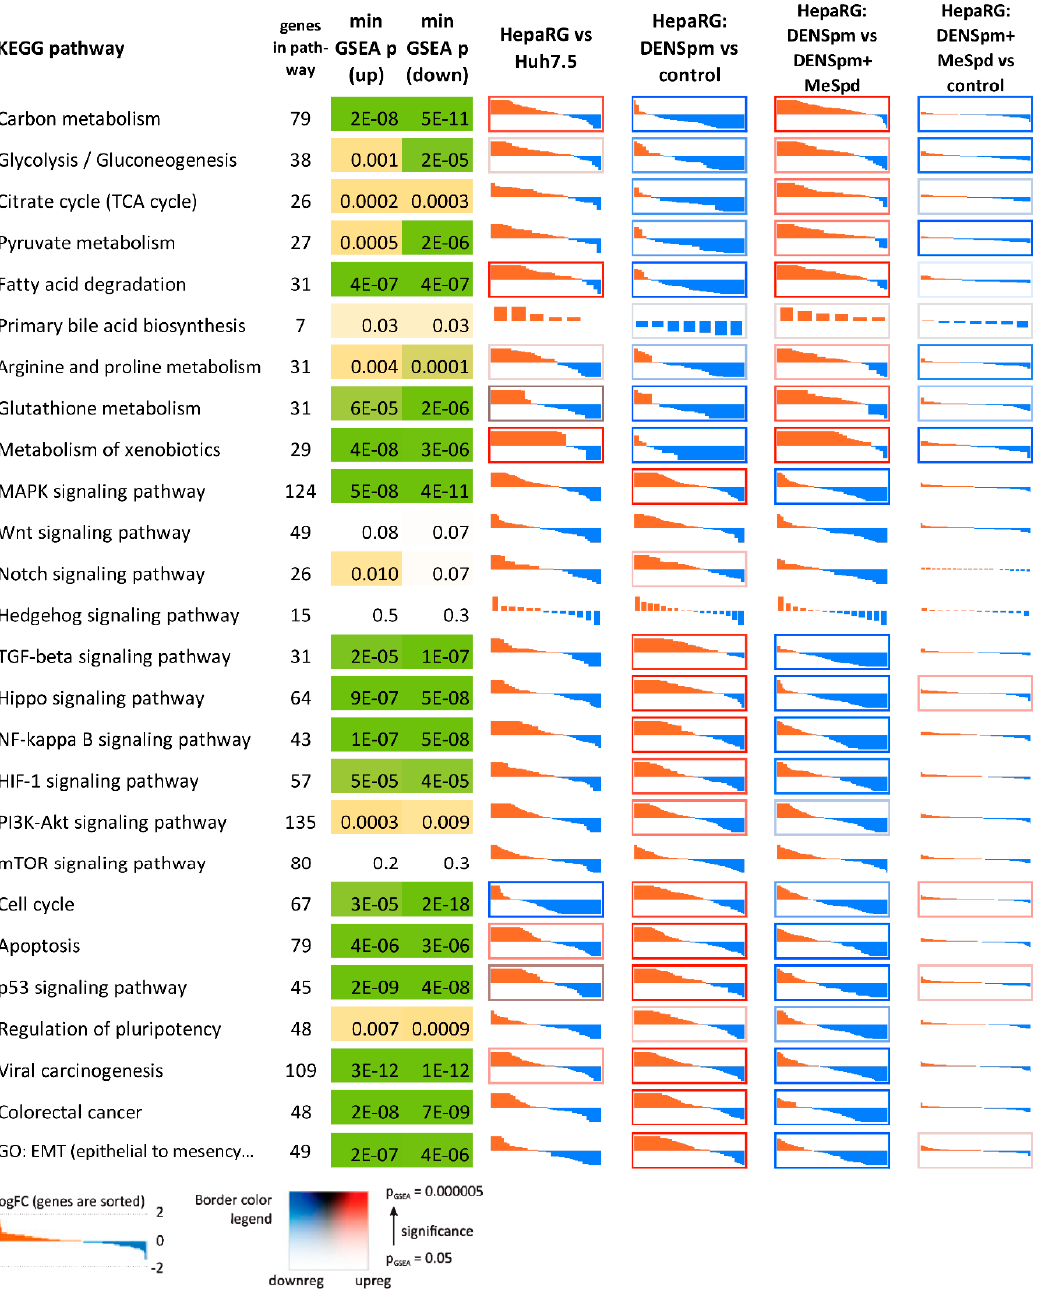
Figure 7. Differential expression profiles of genes involved in the key cell signaling pathways processes (KEGG pathways and two GO terms). Each cell represents log-transformed expression level fold changes (LogFC) of individual genes, sorted from overexpressed (red) to downregulated (blue). In each cell, vertical axis range is from LogFC = − 2 (i.e., 4-fold downregulation; blue) to LogFC = +2 (i.e., 4-fold overexpression; red). Cell borders indicate the gene set enrichment test (GSEA) p -value: blue borders—enrichment with down-regulated genes, red borders—with overexpressed genes. ‘min. GSEA p (up/down)’—minimal GSEA p -value for up/down-regulated genes (across all the